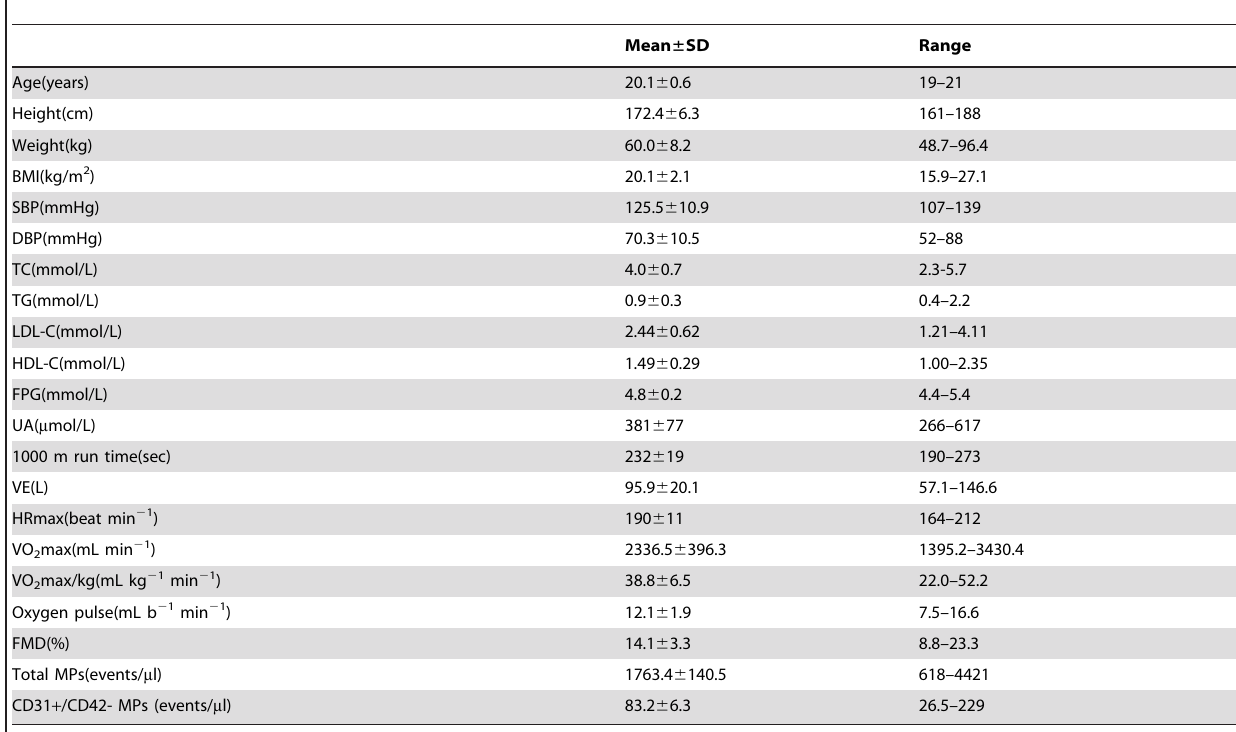
Table 1. Physiological characteristics of the subjects (N=